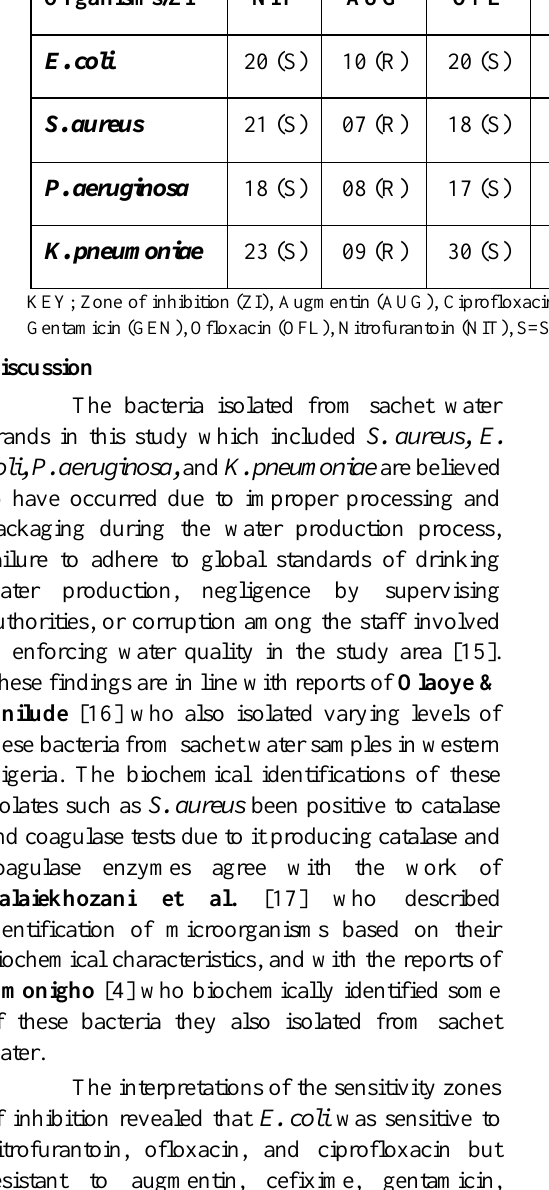
Table 3. Results of antibiogram assay. Organisms/ZI NIT